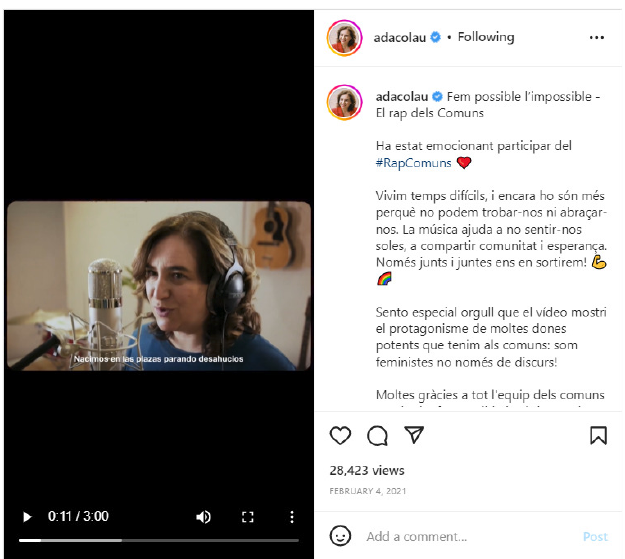
Figure 5. Colau singing “The Commons Rap” on February 4, 2021.